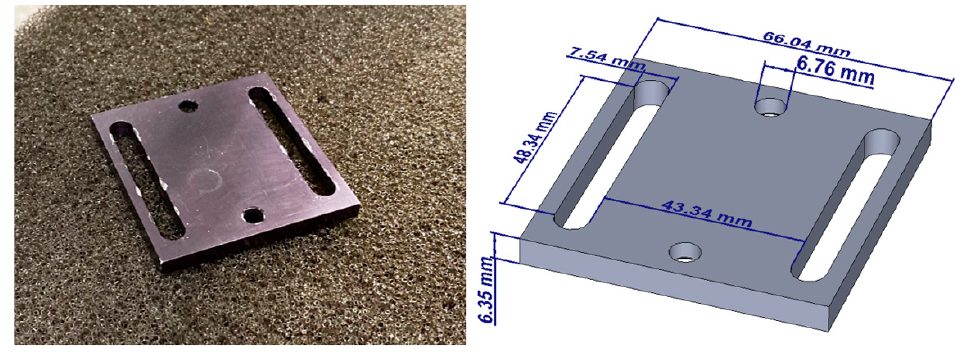
Figure 8. Swept-FM imagine target plate.